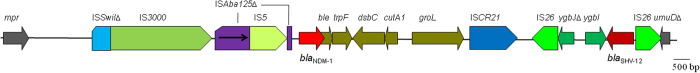
Genetic context of blaNDM-1 in E. coli strain WCHEC13-8.ISAba125 was interrupted by the insertion of IS5. Genes shown from the left in order are mpr (encoding a zinc metalloproteinase), blaNDM-1, ble (mediating bleomycin resistance), trpF (encoding a phosphoribosylanthranilate isomerase), dsbC (encoding an oxidoreductase), ctuA1 (encoding an ion tolerant protein), groL (encoding a chaperonin subunit), ygbI (a putative dehydrogenase gene), a truncated ygbJ (a putative DEOR-type transcriptional regulator gene), blaSHV-12 and a truncated umuD (encoding a mutagenesis protein).